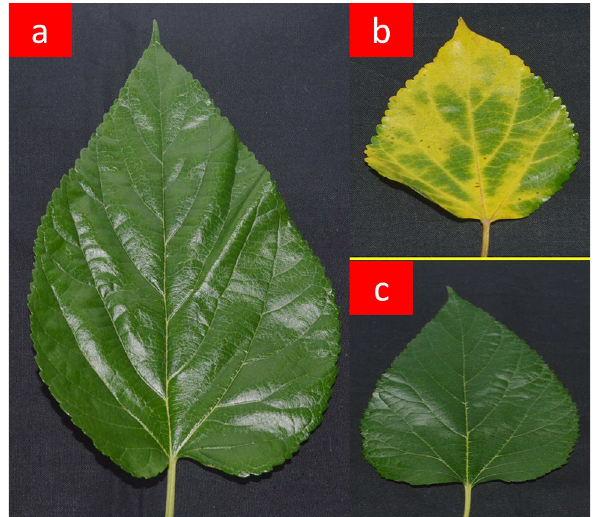
Figure 1. Physical texture of mulberry leaves at the end of preservation period in comparison with fresh leaves. ( A ) Fresh leaf, ( B ) 7 day preserved leaf in distilled water and ( C ) 7 day preserved leaf in nanosilver